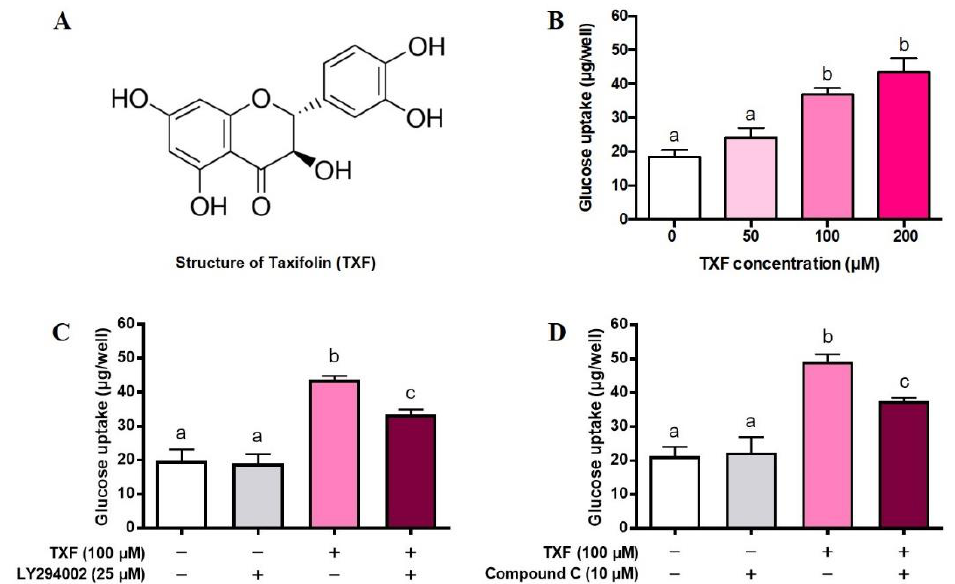
Figure 1. Structure of taxifolin ( A ), dose-dependent effect of taxifolin ( B ), effects of LY294002 ( C ), and Compound C ( D ) on glucose uptake in cultured L6 myotubes for 4 h. Each value represents the mean ± SEM for 6 wells of a 24-multiwell plate. Values not sharing a common letter are significantly different at p < 0.05 by Tukey–Kramer multiple comparisons test.